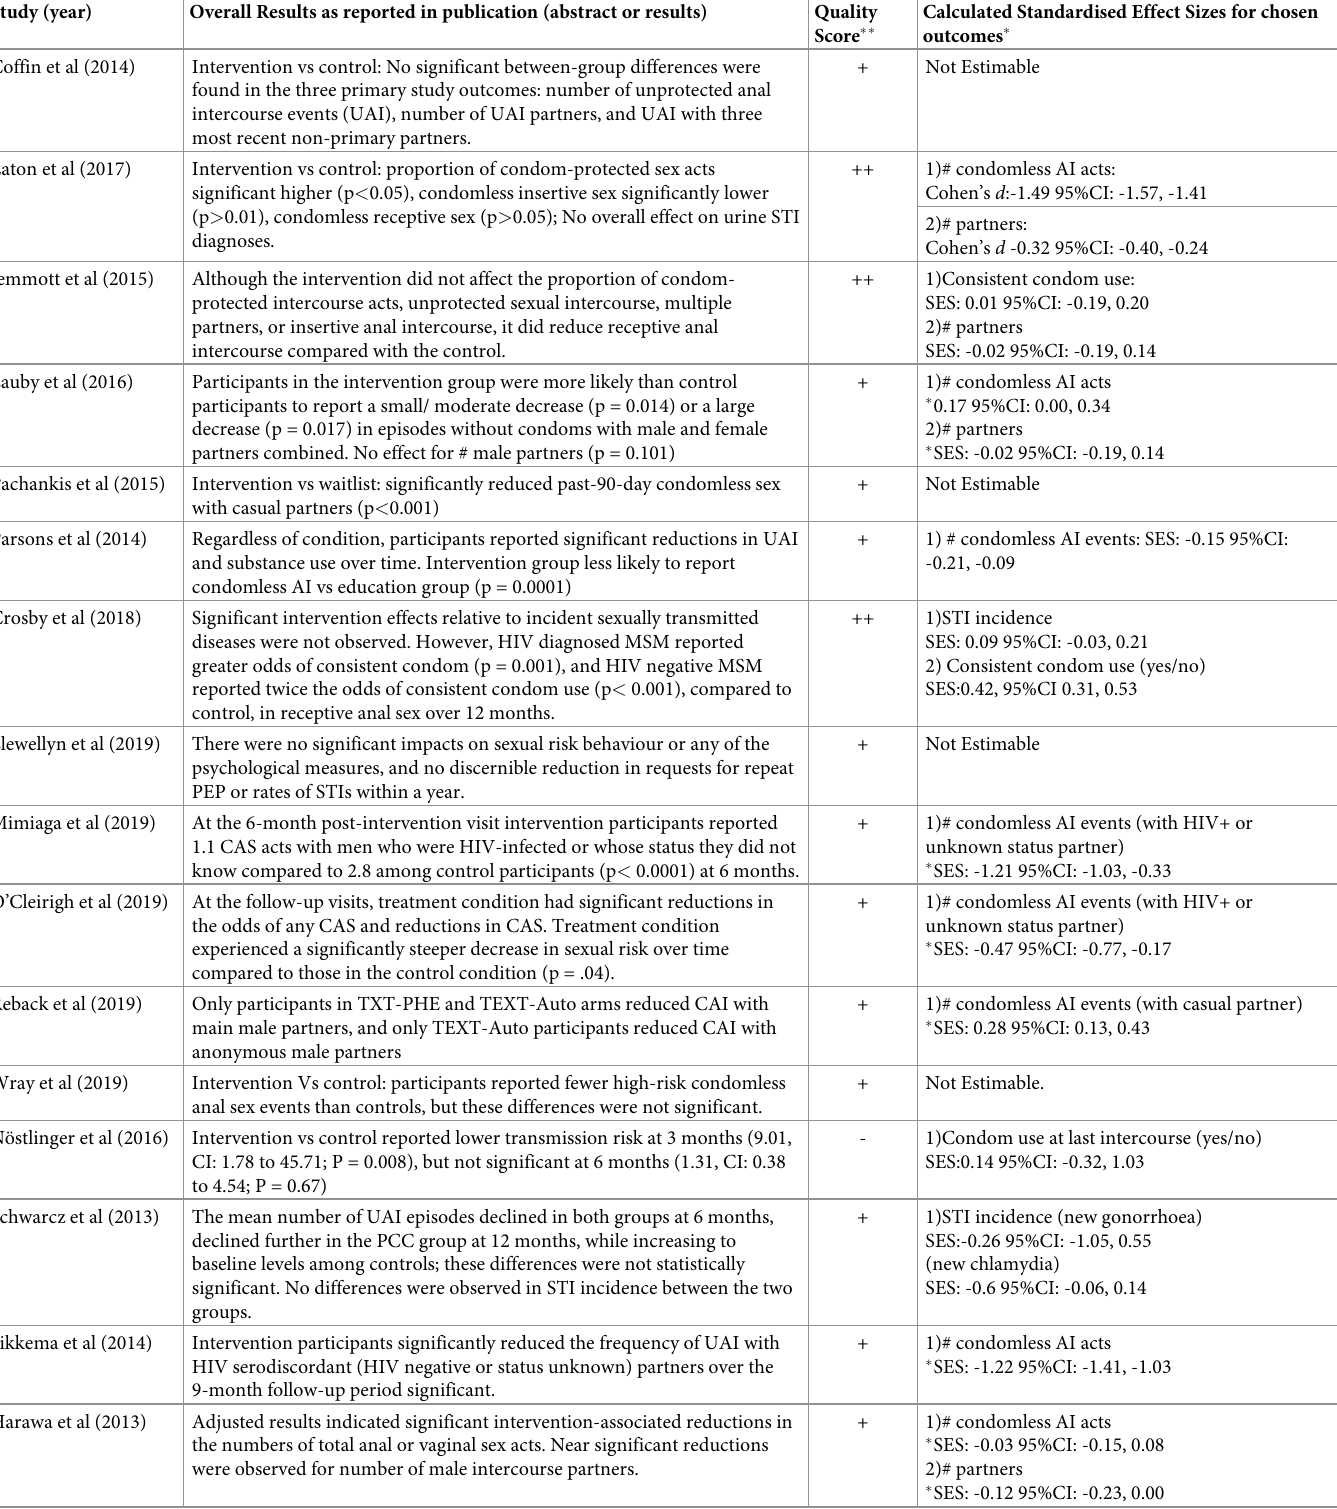
Table 2. Results, quality score and calculated standardised effect sizes for chosen outcomes of randomised controlled trials included in this review. Study (year) Overall Results as reported in publication (abstract or results) Quality